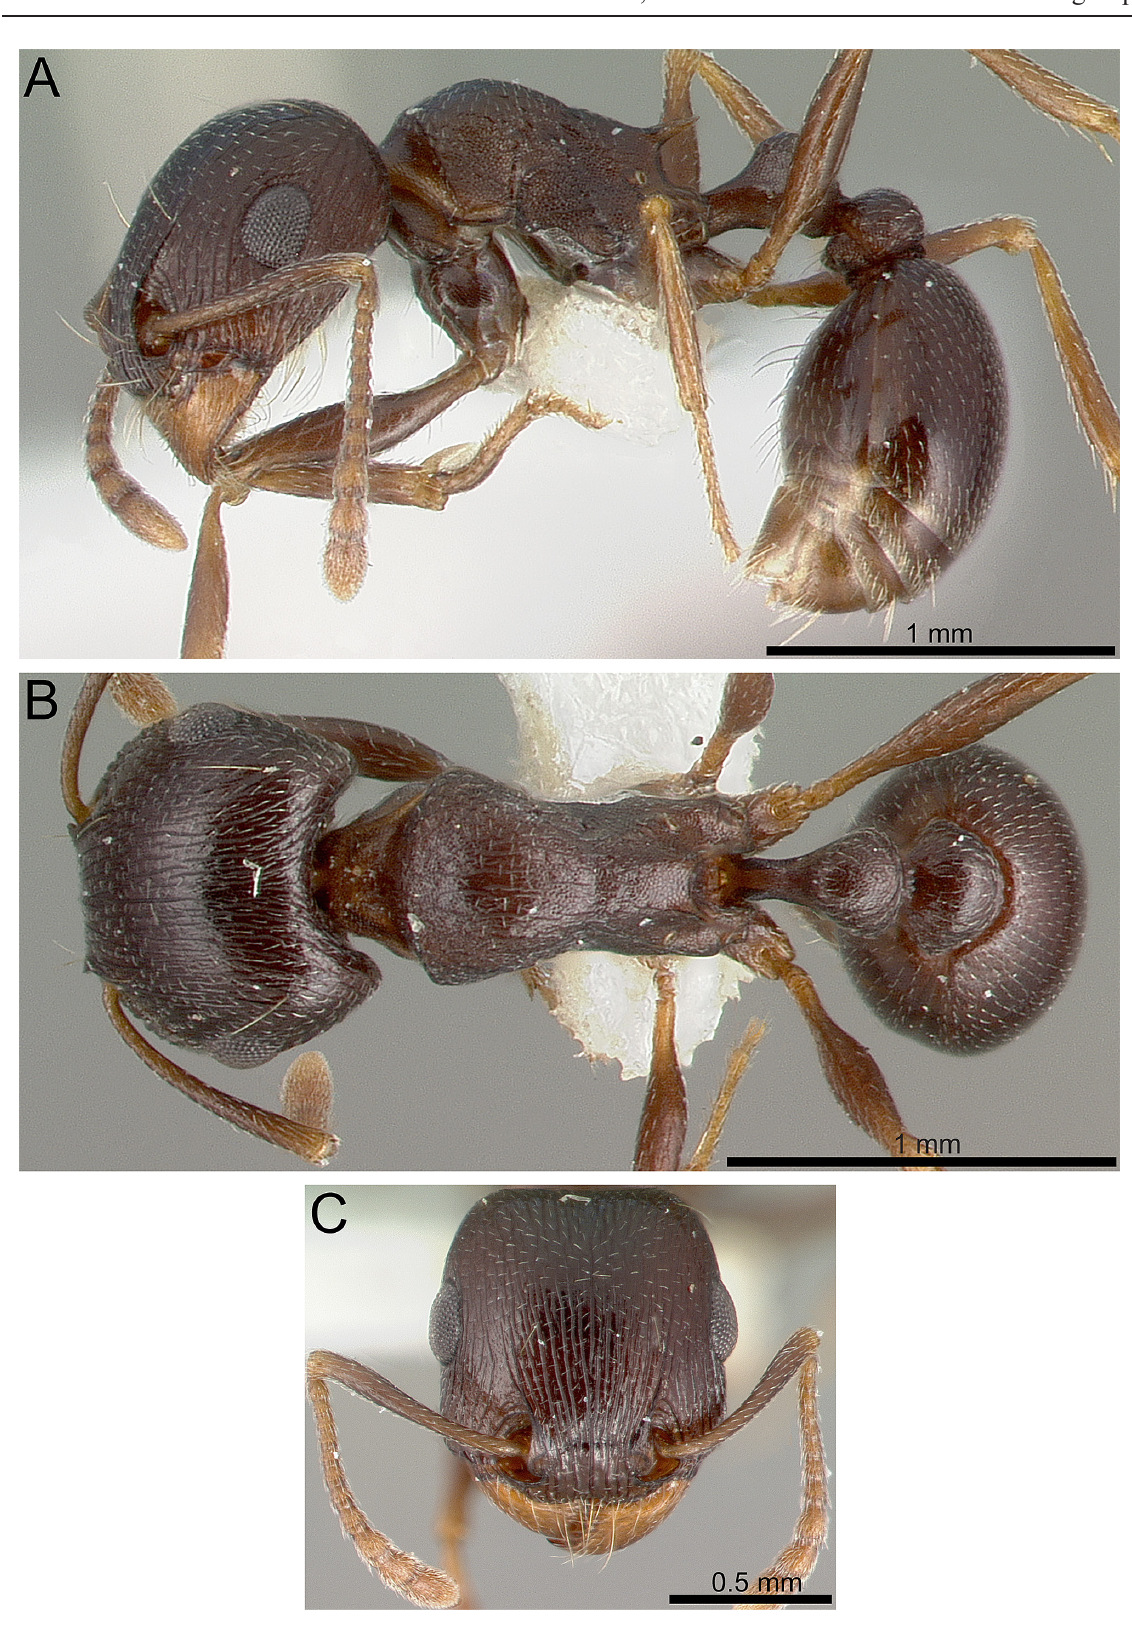
Fig. 18. Tetramorium pogonion Bolton, 1980 (CASTYPE13390 – Antweb, photographer unknown). A . Body in profile. B . Body in dorsal view. C . Head in full-face